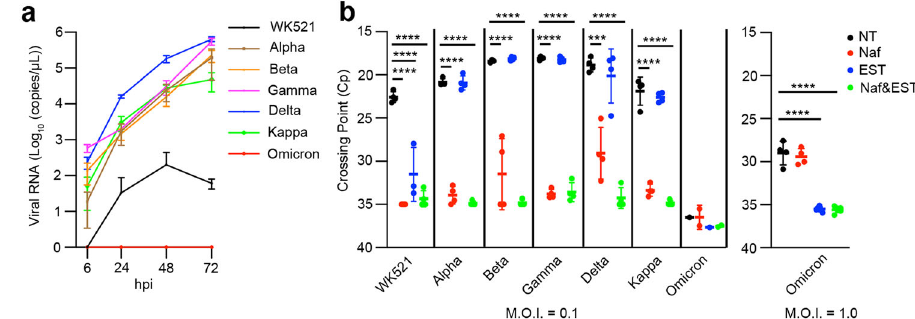
Fig. 2 | Replication ability and entry phenotype of SARS-CoV-2 in Calu-3 cells. a Replication kinetics in cells infected with viruses at an MOI of 0.1. Viral RNA copy numbers in the culture supernatants were quanti fi ed at 6, 24, 48 and 72h p.i. b Cells were infected with viruses at an MOI of 0.1 (left bar graph) or 1.0 (right bar graph) in theabsence(NT)orpresenceofeithernafamostat(Naf)orESTorboth(Naf&EST).At 24h p.i., viral RNAs in cells were detected by real-time RT-PCR. The x-axis shows the Cp values as an indicator of the viral RNA level. a , b Error bars indicate the standard deviationsoftriplicatewells.Meanvalues±SDareshown. b Statisticalsigni fi cancewas determined with two-way ANOVA. Multiple comparisons among different